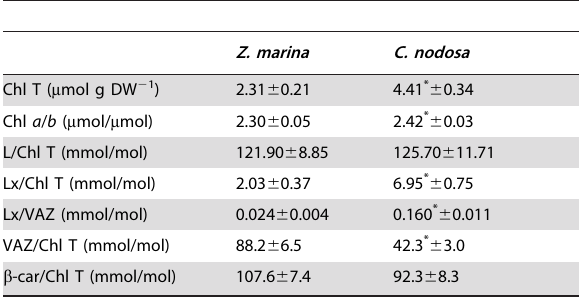
Table 2. Photosynthetic pigment contents and ratios in leaves of Zostera marina and Cymodocea nodosa